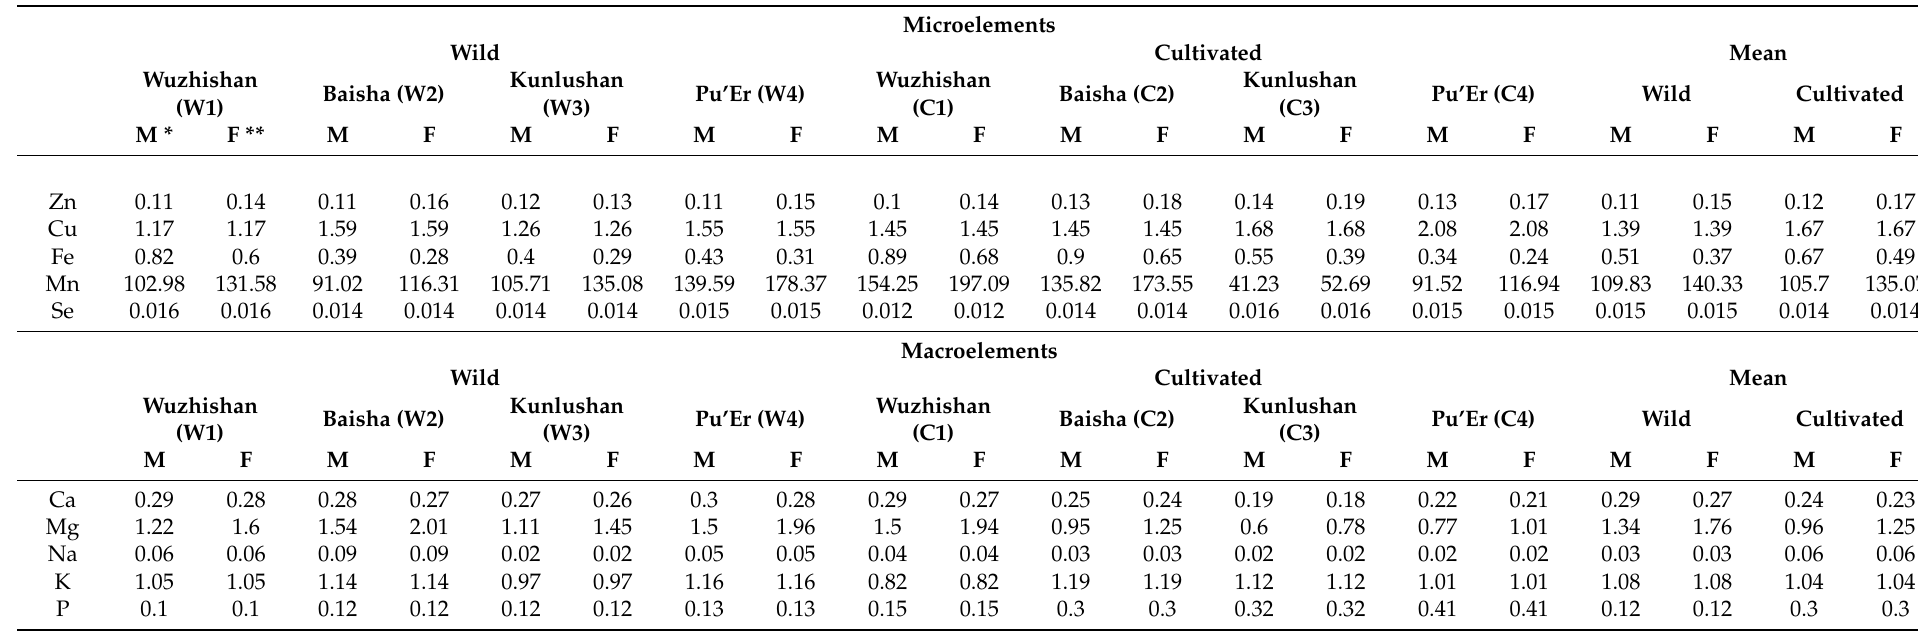
Table 7. Daily dietary intakes (%) associated with the consumption of infusions of tea for adults (19 years and over) of micro- and macroelements with regard to dietary reference intakes